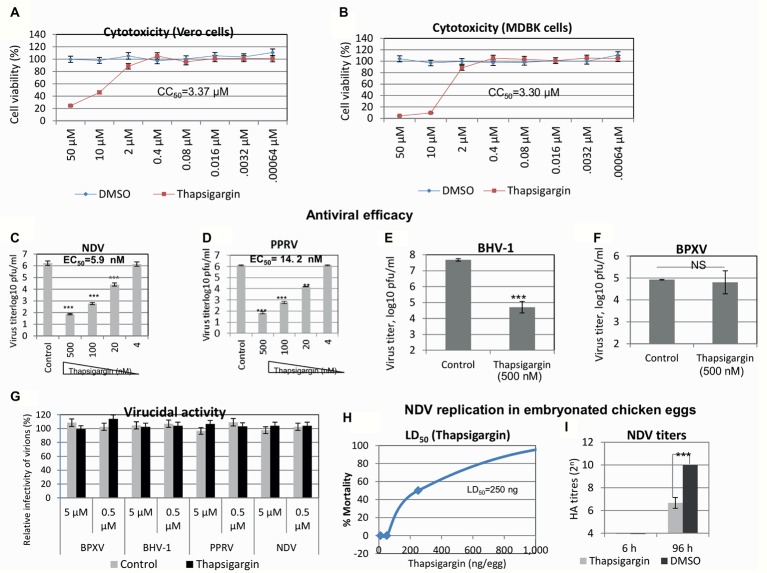
Antiviral efficacy of Thapsigargin. Cytotoxicity (MTT assay): five-fold serial dilutions of Thapsigargin (50–0.00064 μM) or equivalent volume of vehicle control (0.05% DMSO) were incubated with cultured Vero/MDBK cells for 96 h, and percentage of cell viability was measured by MTT assay. Cell viability of Vero (A) and MDBK (B) cells is shown. Antiviral efficacy: Vero/MDBK cells were infected with respective viruses at MOI = 0.1 in the presence of indicated concentration of Thapsigargin or vehicle control (0.05% DMSO). Progeny virus particles released in the supernatants were quantified by plaque assay. Antiviral efficacy of Thapsigargin against NDV (C), PPRV (D), BHV-1 (E), and BPXV (F) is shown. Virucidal activity: 10-fold dilutions of the Thapsigargin or DMSO were mixed with ~106 pfu of the indicated viruses and incubated for 1.5 h at 37°C. Thereafter, the residual viral infectivity was determined by plaque assay in Vero (NDV, PPRV, and BPXV) or MDBK (BHV-1) cells (G). Effect of Thapsigargin on replication of NDV in embryonated chicken eggs. Embryonated SPF chicken eggs, in triplicates, were inoculated with indicated concentration of Thapsigargin via allantoic route. At 96 h post-Thapsigargin inoculation, eggs were visualized for viability of the embryos. LD50 was determined by the Reed-Muench method (H). To analyze the effect of Thapsigargin on NDV replication in ovo, embryonated SPF chicken eggs, in triplicates, were infected with NDV via allantoic route, along with administration of Thapsigargin (10 ng/egg). At 6 and 96 hpi, the allantoic fluid was examined for NDV yield by HA (I). Error bars indicate SD. Pair-wise statistical comparisons were performed using Student’s t test (** = p < 0.01, *** = p < 0.001). NS represents no statistical significance.